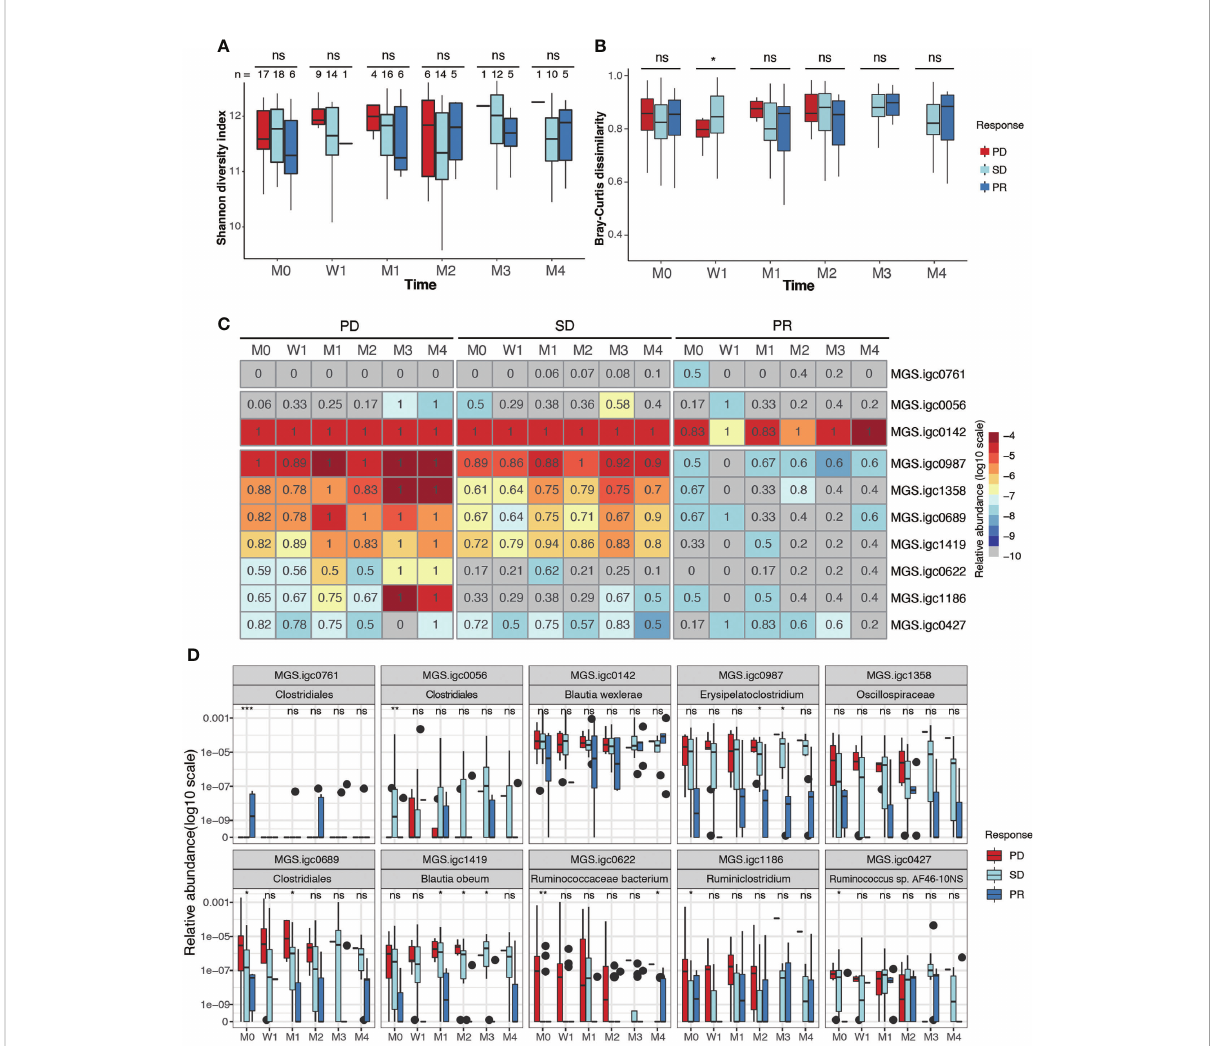
FIGURE 3 Identi fi cation of gut bacterial species associated with clinical response to anti-PD-1 therapy. (A, B) . Box plots showing Shannon alpha diversity (A) and Bray-Curtis dissimilarity (B) based on MGSs in fecal samples collected from PD, SD and PR patients during different stages of anti-PD-1 therapy. (C) Relative abundance (color) and prevalence (numerals) of differentially abundant MGSs among PR, SD and PD groups before treatment, as de fi ned by analysis of variance (ANOVA). The color represents the median value (log10) of relative abundance within the response group. The prevalence rate is indicated as a numeral within the box. (D) Box plots showing the relative abundance of MGSs that exhibit differential abundance between groups. P values were calculated using the Kruskal-Wallis test (ns, non-signi fi cant; * P < 0.05; ** P < 0.01; *** P < 0.001). M0: pre-therapy, W1: one-week post-treatment, M1-M4: 1-4 months